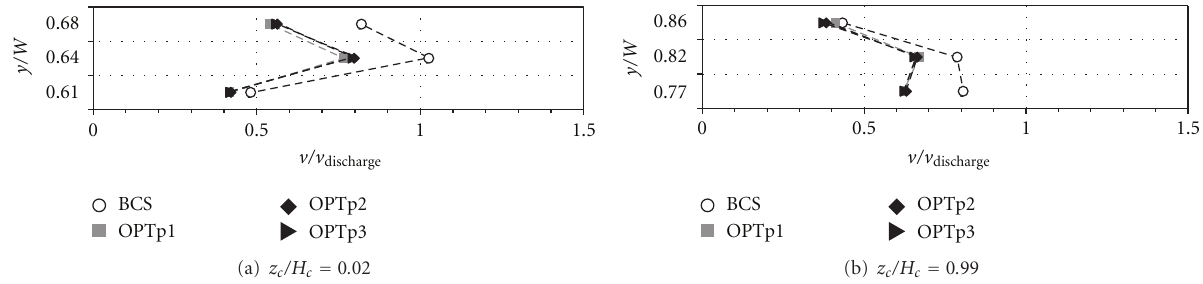
Figure 6: Comparative profiles of nondimensional air velocity, v/v discharge ( y/W , z c / H c ), in the air curtain—OPTp cases study.